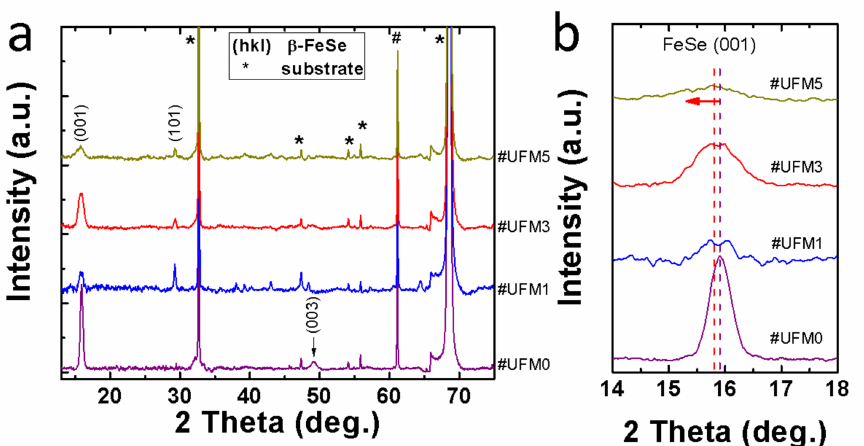
Figure 1. X-ray diffraction (XRD) θ -2 θ patterns of #UFM0, #UFM1, #UFM3 and #UFM5. (hkl) signs represent the diffraction peaks of β -FeSe, while asterisk signs are originated from CaF 2 substrate. ( a ) 2 θ ranges from 12 ◦ to 75 ◦ ; ( b ) A magnified interval near β -FeSe (001) peak from 14 ◦ to 18 ◦ . The peak position of #UFM0 and #UFM3 are marked by dashed lines, indicating a clear peak shift of FeSe (001) toward lower 2 θ angle in Mg-coated